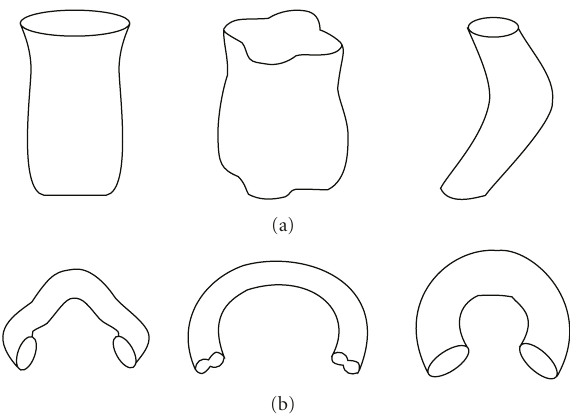
Figure 1: Several examples of generalized cylinders. (a) Straight homogeneous generalized cylinders. (b) Planar, right constant cross section generalized